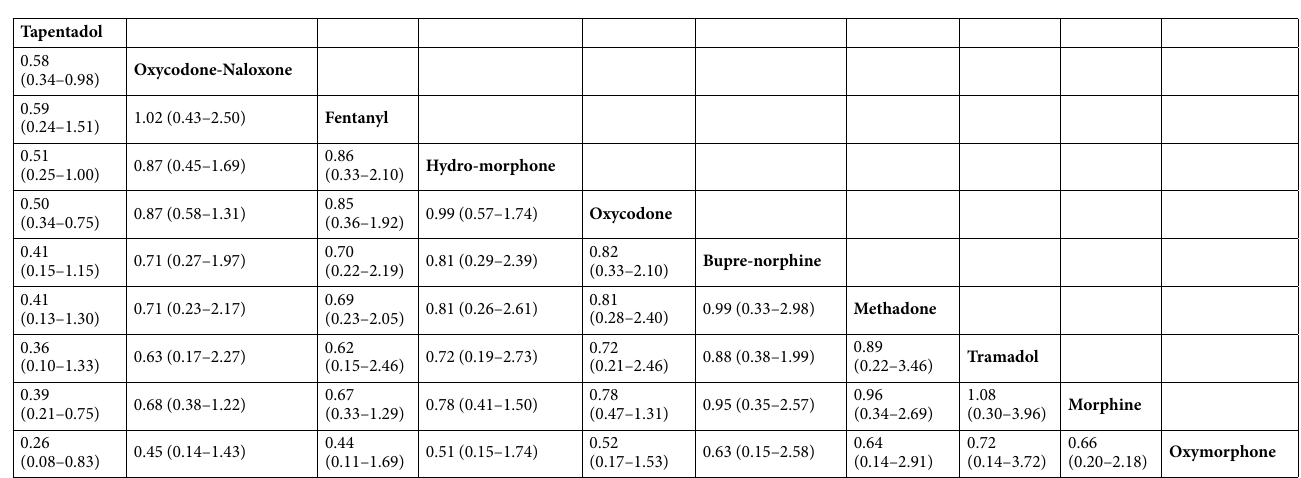
Table 4. League table showing the odds of TRIAL WITHDRAWAL with the treatment of various opioids. OR < 1 means the treatment in top left is